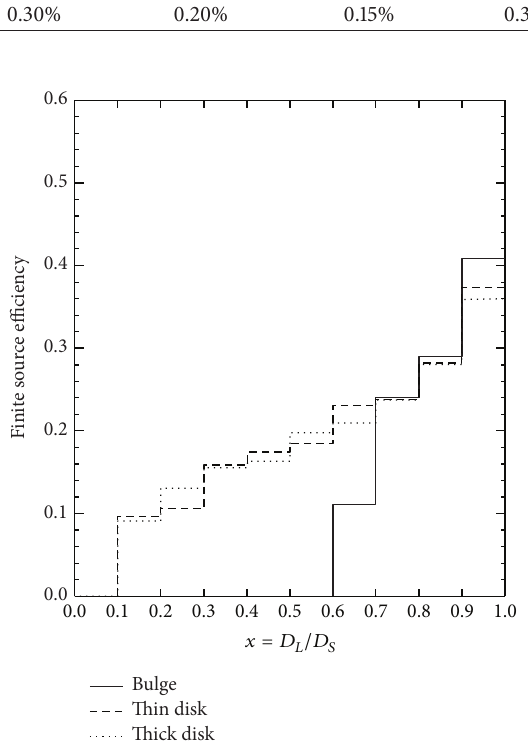
Figure 5: The finite source efficiency for microlensing events by FFPs as a function of 𝑥 for the three different distributions of FFPs: bulge (continuous line), thin disk (dashed line), and thick disk (dotted line). The plot is for 𝛼 𝑃𝐿 = 1.3